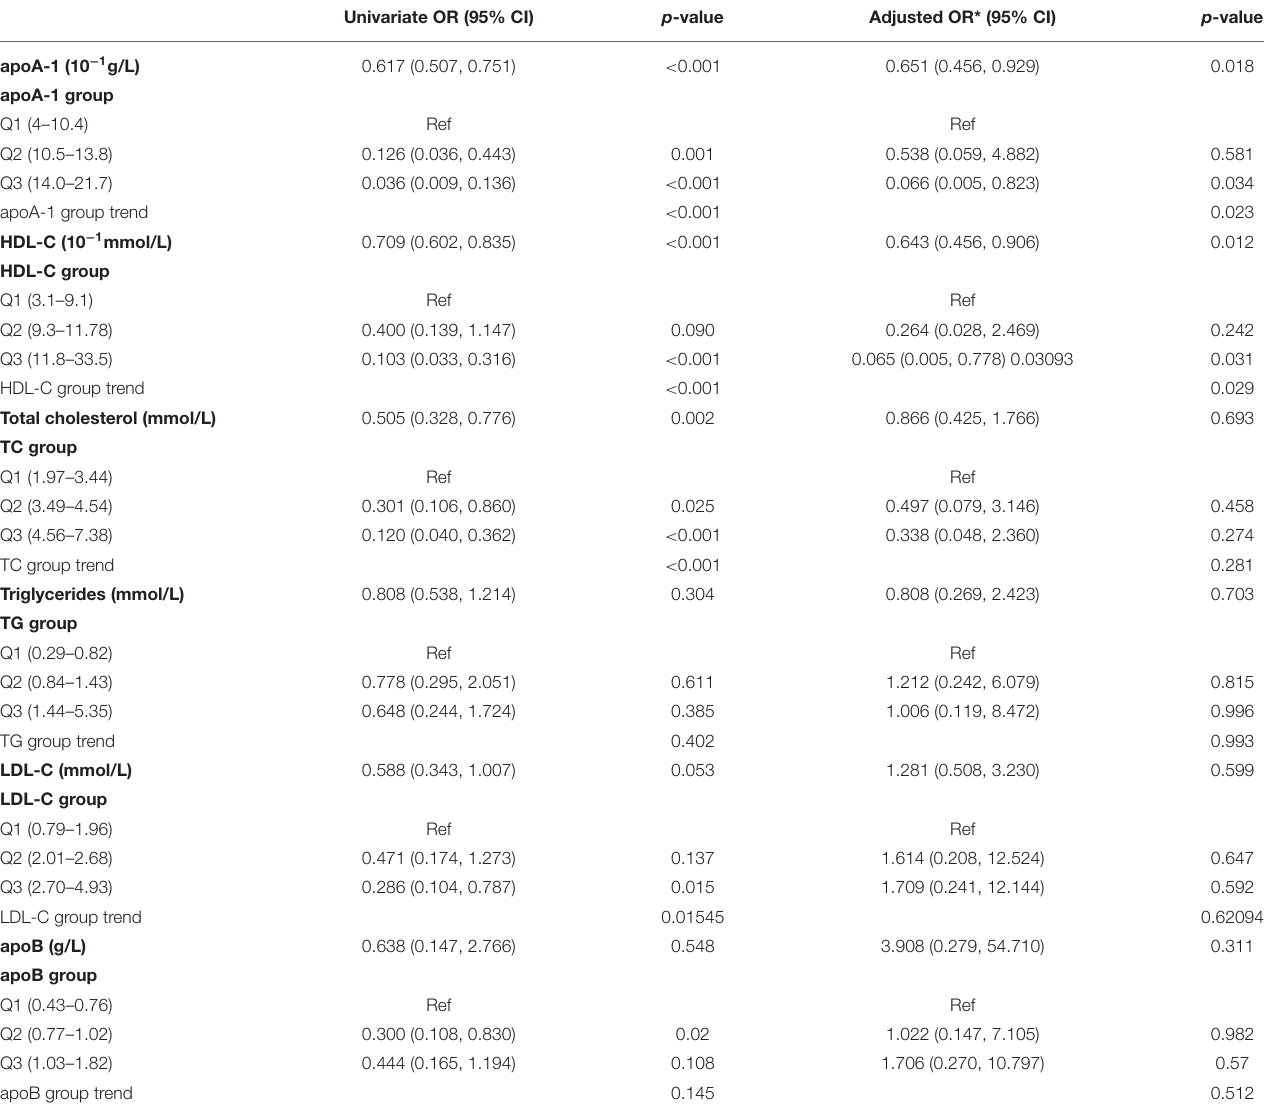
TABLE 2 | Logistic regression analysis for severity in COVID-19